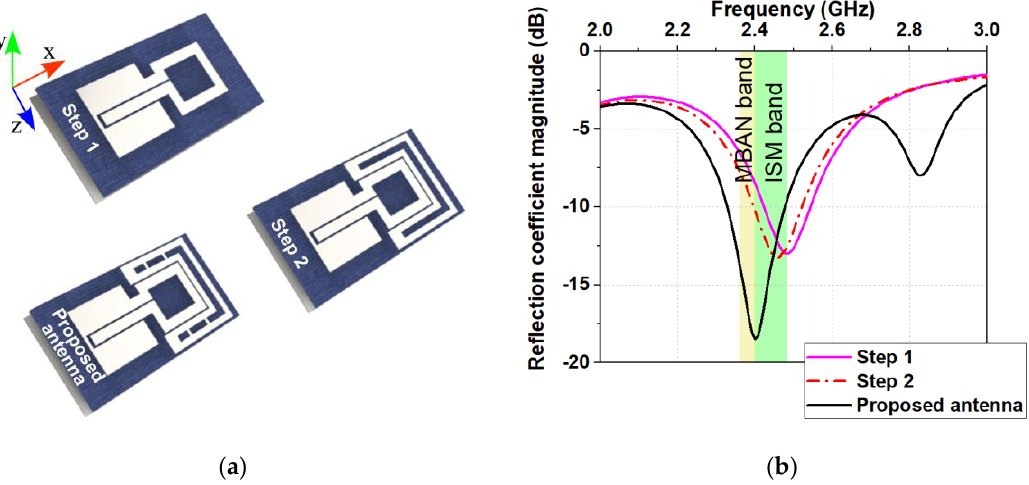
Figure 2. Antenna geometry: ( a ) Design steps; ( b ) Simulated reflection coe ffi cient magnitudes versus frequency.